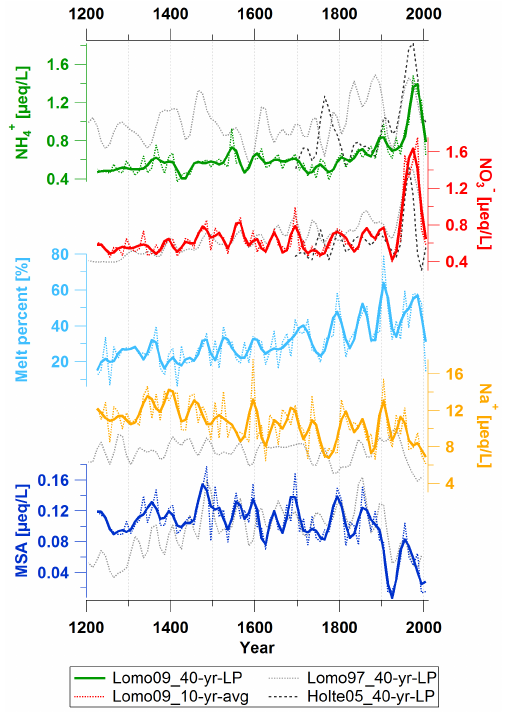
Figure 4. Records of NH + (green), NO − (red), melt percent (light 4 3 blue), Na + (yellow), and MSA (dark blue) of the Lomo09 ice core. Bold lines are 40-year low-pass-filtered (40-yr-LP); dashed lines are 10-year averages (10-yr-avg). Raw data are available in the Supple- ment (Figs. S2 and S3). Grey dashed lines are 40-year low-pass- filtered records of NH + , NO − , Na + , and MSA of the Lomo97 ice 4 3 core (Kekonen et al., 2005) calculated with the updated chronology of Divine et al. (2011). Black dashed lines are 40-year low-pass- filtered records of NH + and NO − of the Holte05 ice core (Beaudon 4 3 et al., 2013).